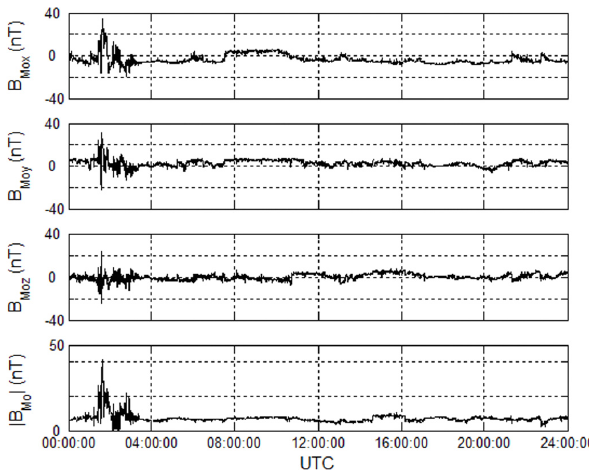
Fig. 10. 24h of 1Hz VEX MAG science data from the orbit on 9 June 2006 and plotted in the Venus-Sun-Orbit co-ordinate